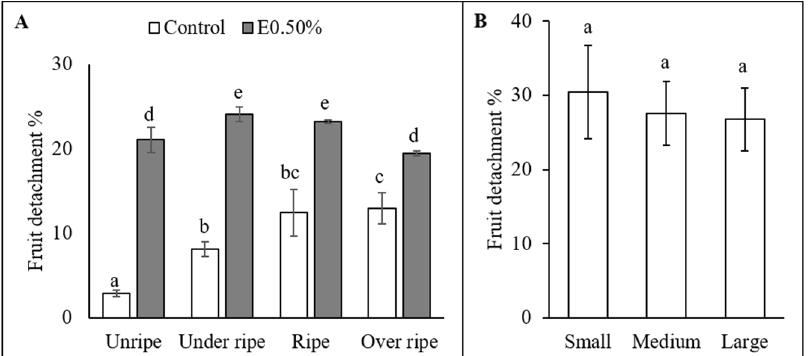
Figure 2. Fruit detachment (%) in different categories of oil palm fruit bunches ripeness and bunch size. The impact of ( A ) bunch ripeness and ( B ) bunch size on fruit detachment after treatment with 0.50% ethephon for 24 h applied by evaporation method. The data were presented as means of the replicates ( n = 5) and vertical bars indicate the standard deviation. Means that do not share a letter were significantly different at p < 0.05 according to Tukey’s range test.